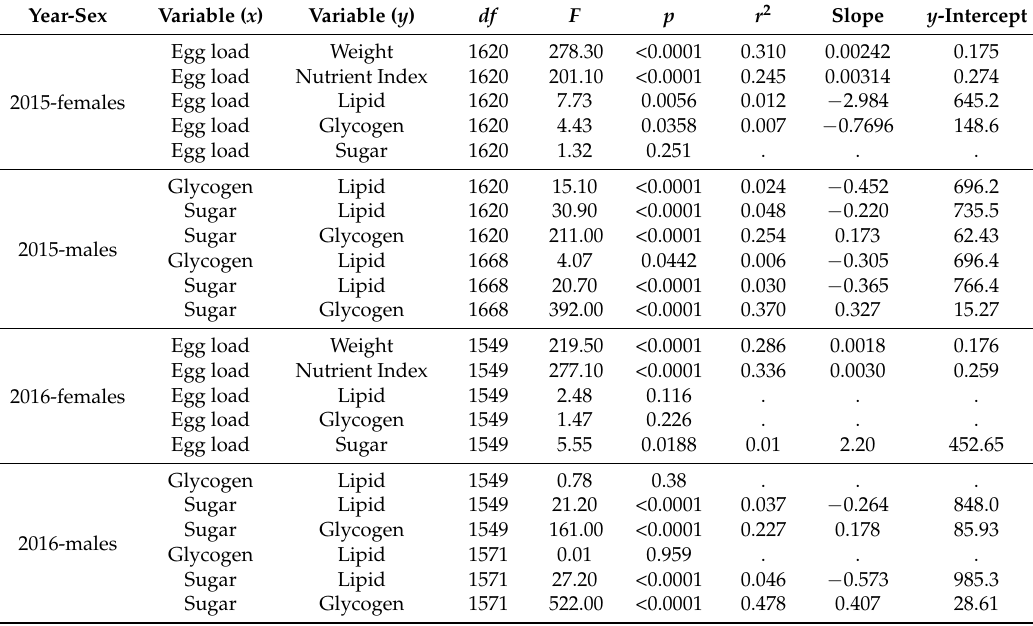
Table 4. Regression analyses of BMSB egg load and nutrient